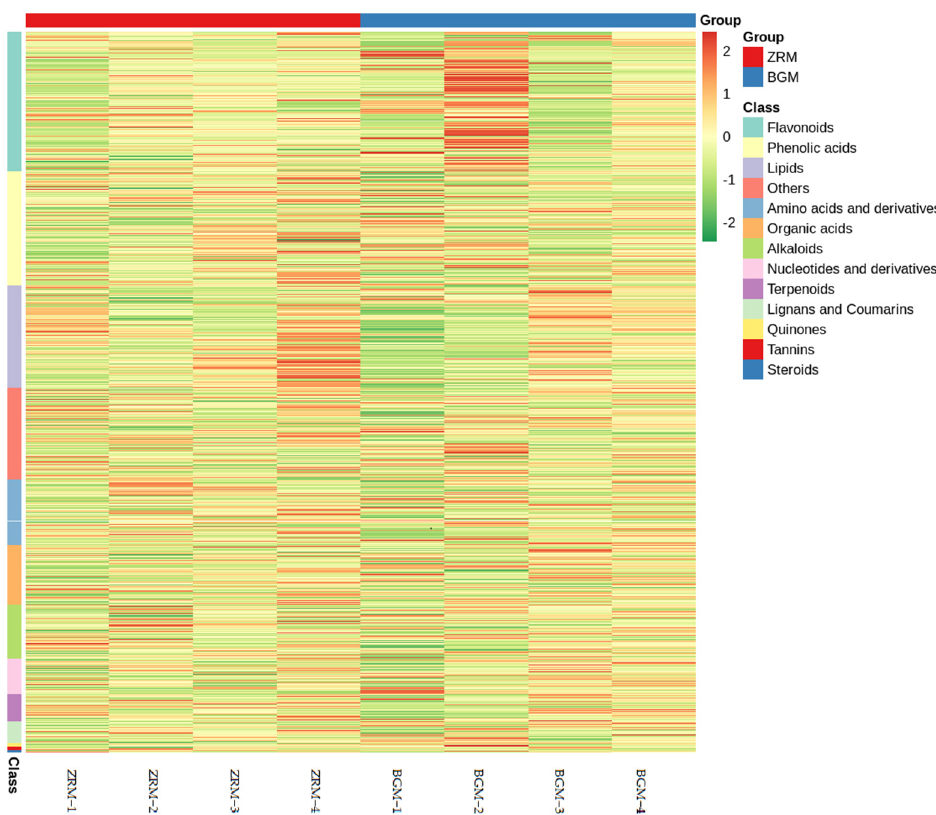
Figure 1. Heatmap visualization of 1102 detected metabolites in P. amarus bamboo shoots grown under shading treatment and normal growing conditions. Different colors in the cluster heat map are the values obtained after the standardization of relative content (red represents high content, green represents low content). BGM: shading group, ZRM: control group.